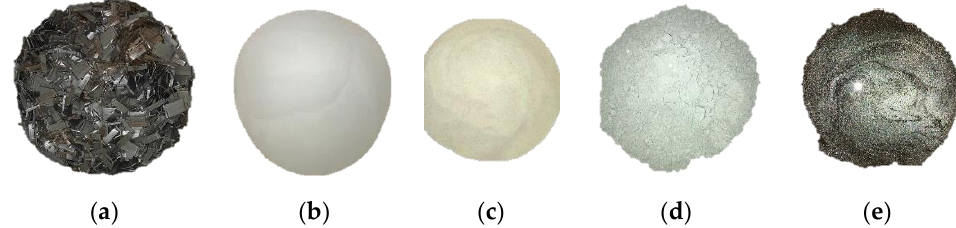
Figure 1. Materials used in the preparation of UHPC mix. ( a ) Steel fiber. ( b ) Silica fume. ( c ) White sand. ( d ) Cement. ( e ) Superplasticizer. Table 1. Chemical compositions of cement and silica fume. Chemical Composition (%)